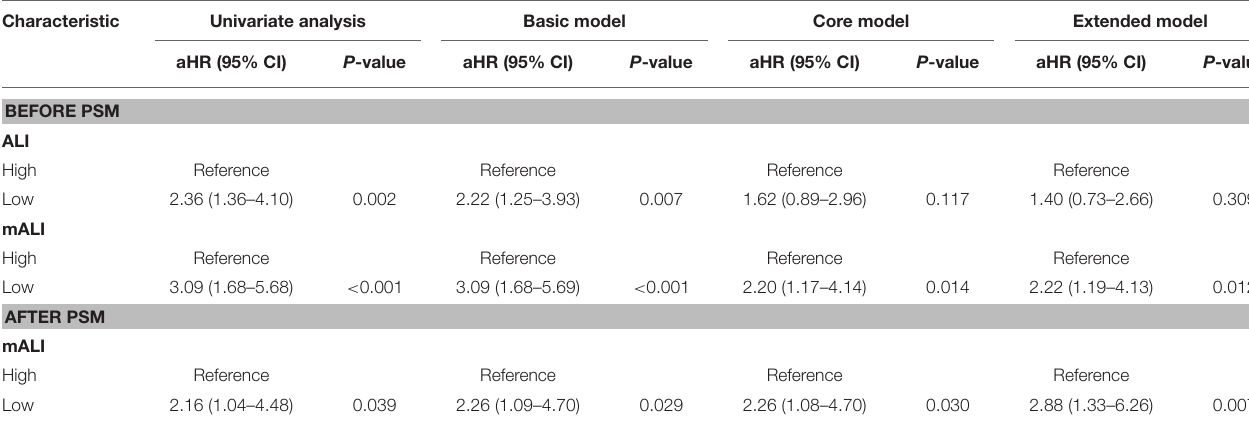
TABLE 2 | Relative risk of overall survival (OS) was calculated according to ALI and mALI a